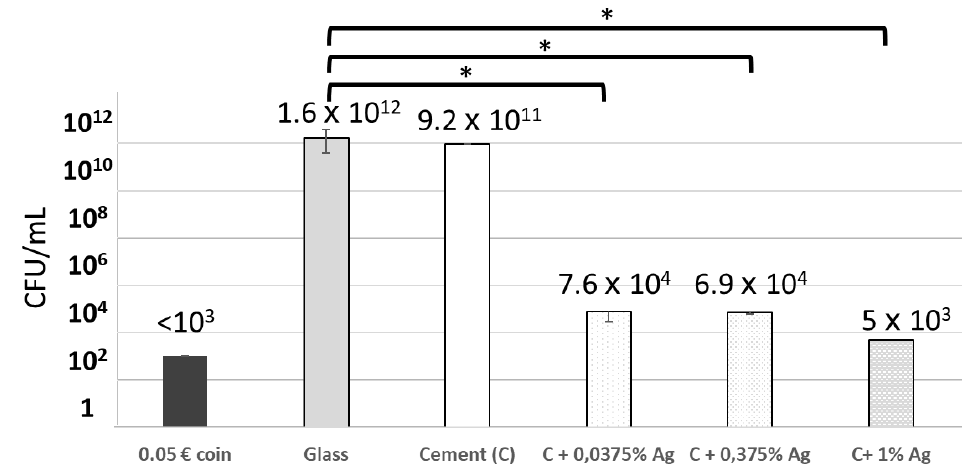
Figure 3. Surviving S. aureus (in CFU/mL) after 24 h contact with cements enriched with different silver percentages. Test carried out five times (* p -value < 0.05).